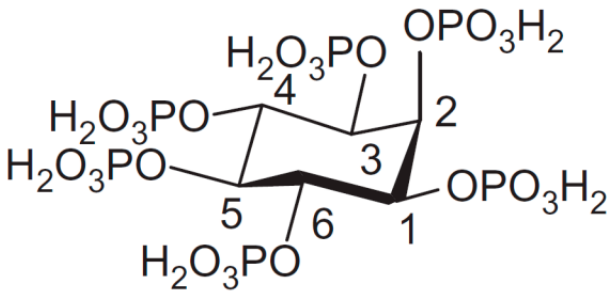
Figure 1. Structure of phytic acid in equatorial conformation.